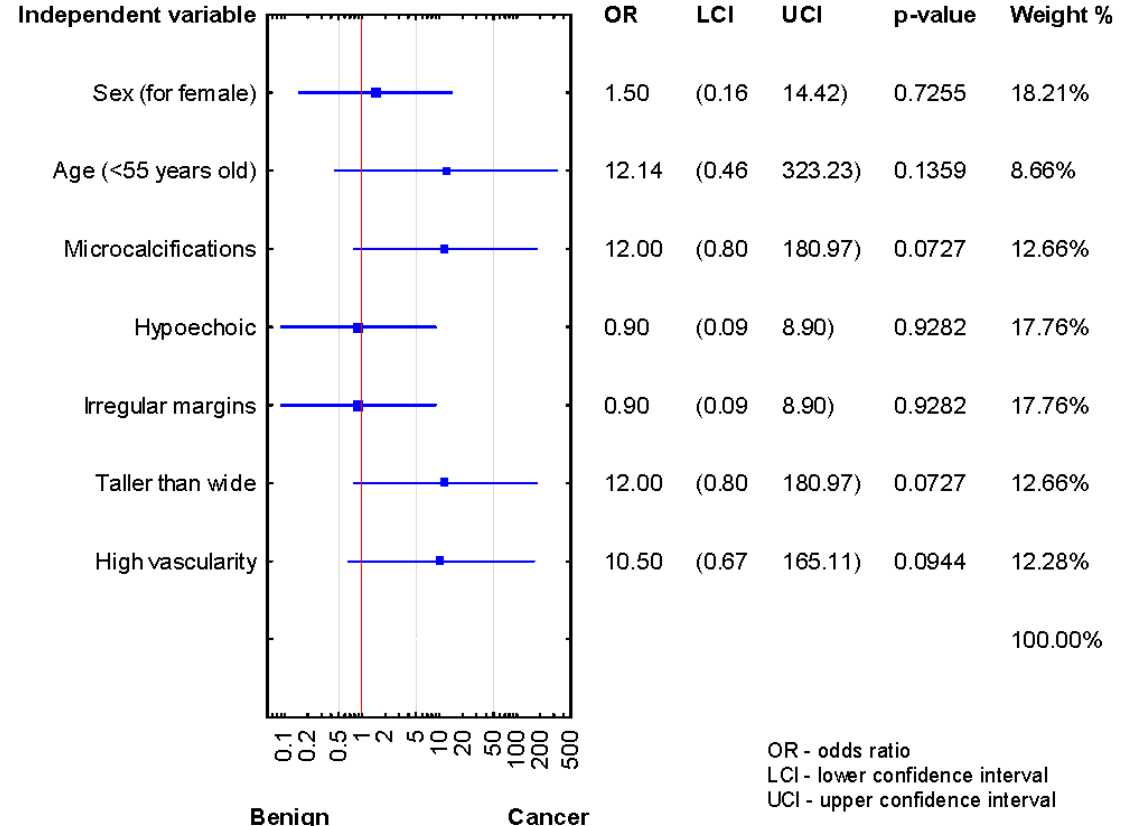
Figure 4. Forrest plot showing the odds ratios for cancer risk in the patients after the third diagnosis of AUS/FLUS ( n = 13).